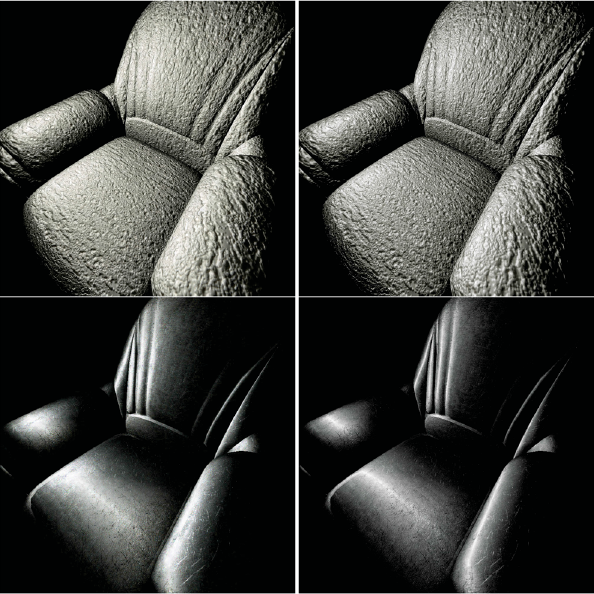
Fig. 16 Visual comparison of original (left) and compressed (right) ABTF datasets, captured from two different physical material samples “Ingrain” (above) and “Metal” (below). Both material samples feature a wide spectrum of optical effects like self shadowing and anisotropic reflections, which are successfully reconstructed by the fitting model presented in this work.